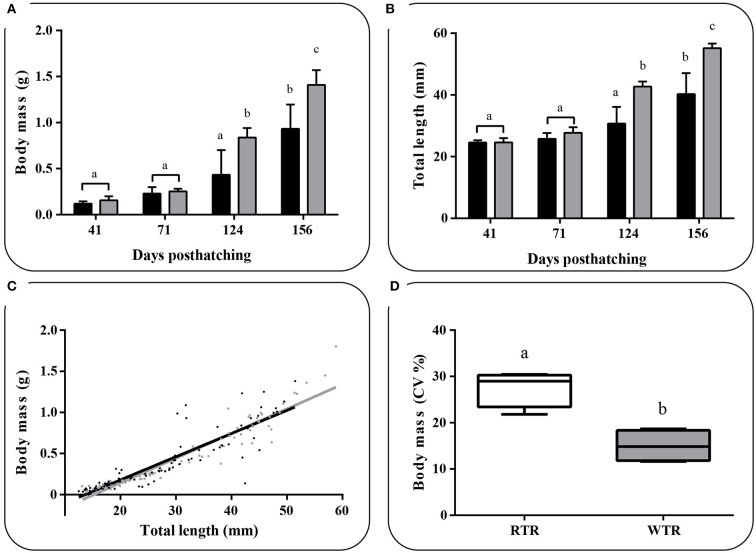
Effect of thermal range in Salmo salar growth during the development (156 days post-hatching), expressed as (A) changes in body weight, (B) changes in body total length, (C) weight/length relationship and (D) Box and whiskers plots registered differences in coefficients of variation for body weight. Values are represented as the mean ± SD. The experimental groups were: restricted thermal range (RTR, ΔT 1.4°C; black) and wide thermal range (WTR, ΔT 6.8°C; gray). Different letters denote significant differences between groups (2 way ANOVA; Two-tailed Student's t-test; p < 0.05).